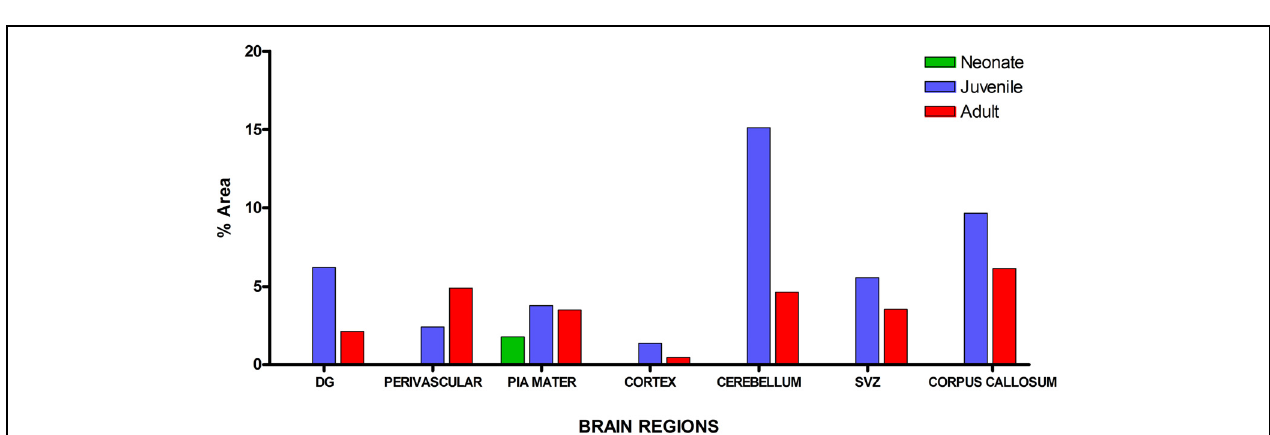
FIGURE 2 | Quantitative analysis of glial fibrillary acidic protein (GFAP) signal intensity in selected brain regions across age groups revealed greatest signal values per unit area in juveniles followed by adults and neonates, respectively.